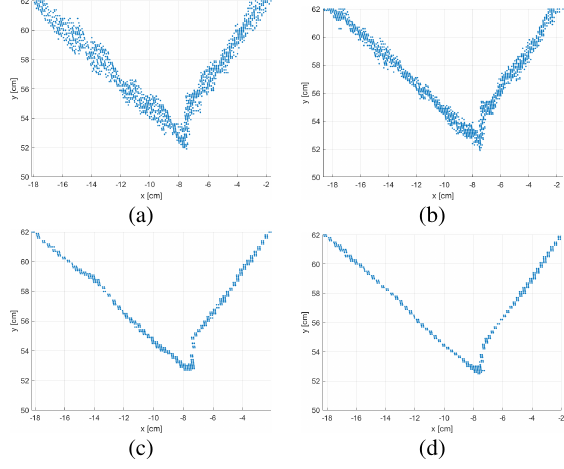
Figure 8. Top views of 2 cm-height slices of a point cloud acquired with PicoZense DCAM710 on the corner between two sides of a closet. Comparison between the different operative Figure 7. (a) Average of the absolute values of depth differences modes of the TOF camera: (a) standard, (b) time averaging, (c) computed on successive time sequences. (b) Average of the spatial averaging, (d) time and spatial values of depth differences computed on successive time sequences.